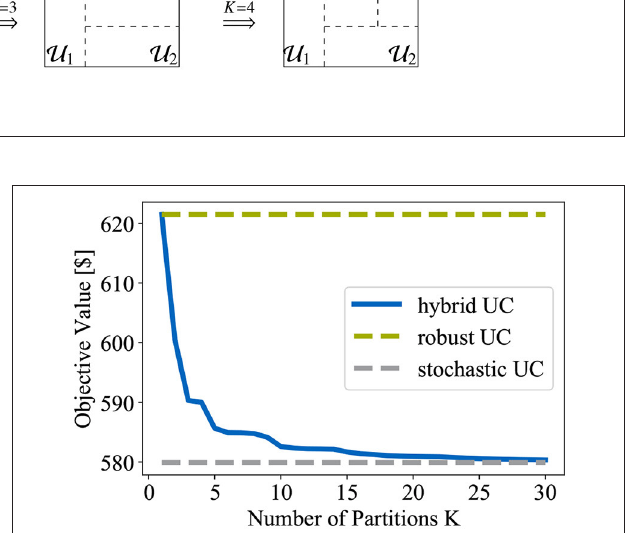
FIGURE 5 | Comparison of solution to HUC with solutions to RUC and SUC.